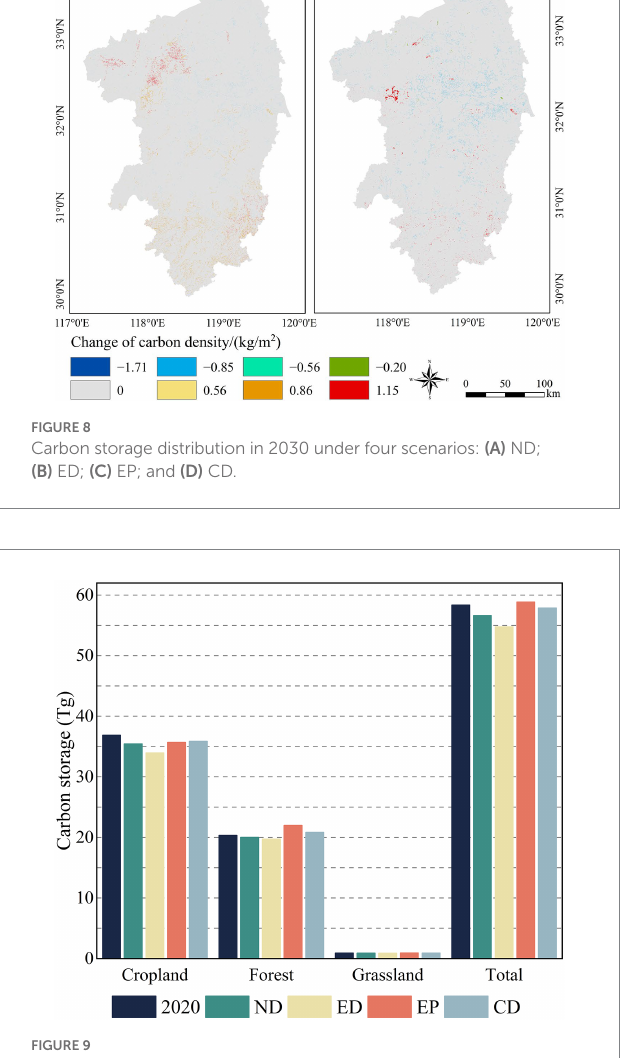
FIGURE 9 Sequestered carbon content of different land uses over 2020–2030 under four